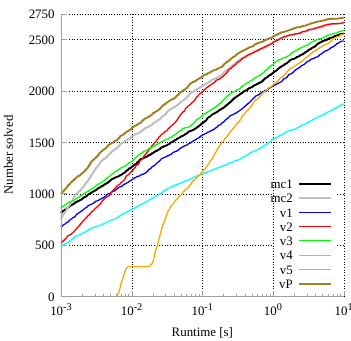
Figure 9. Cumulative number of instances (y-axis) solved under a certain time (x-axis) for all sequential and parallel versions plus the portfolio